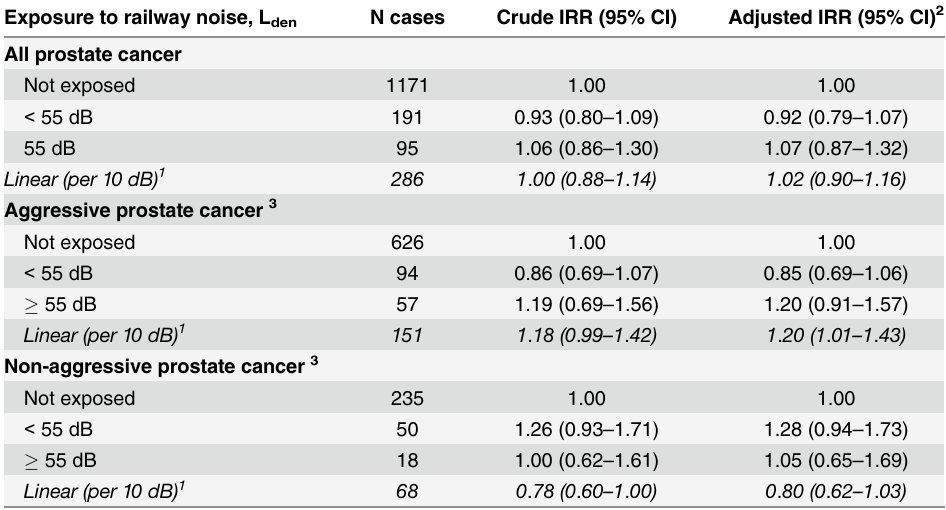
Table 3. Incidence rate ratio (IRRs) of prostate cancer according to railway noise exposure.